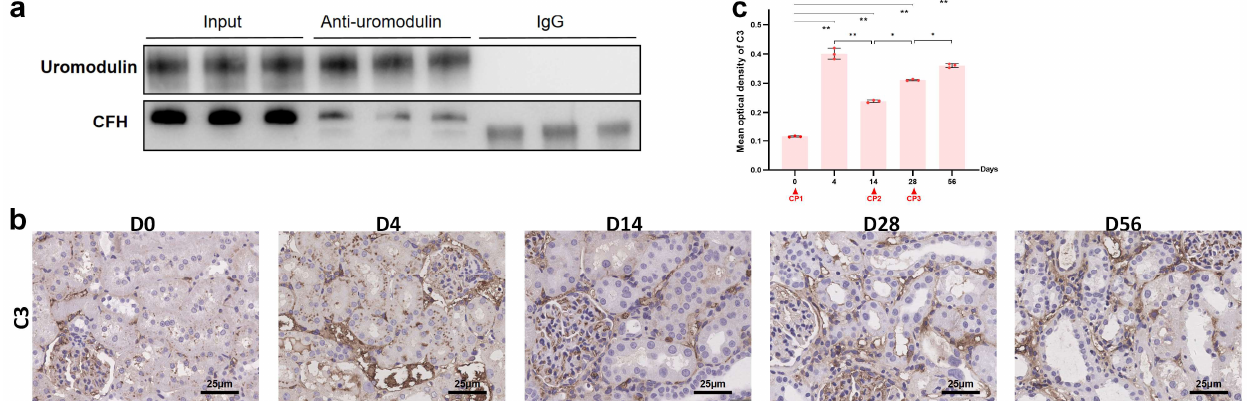
Figure 6. Interaction between uromodulin and CFH in rat kidneys and complement activation during AKI-to-CKD transition. ( a ) Total protein lysates of normal rat kidneys were immunoprecipitated using an antibody against uromodulin and immunoblotted against CFH. ( b ) Representative micrographs (40 × , bar = 25 µ m) and ( c ) quantification of positive-stained C3 on kidney sections on different days as indicated (n = 3). * p < 0.05, ** p < 0.01 between the two groups. CP, cisplatin.